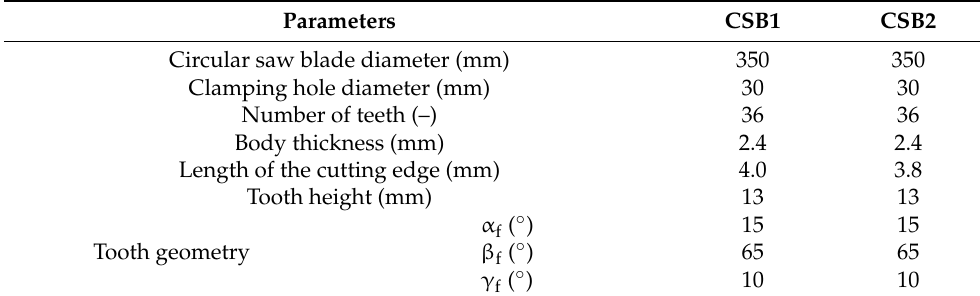
Table 2. The basic parameters of the circular saw blades used.